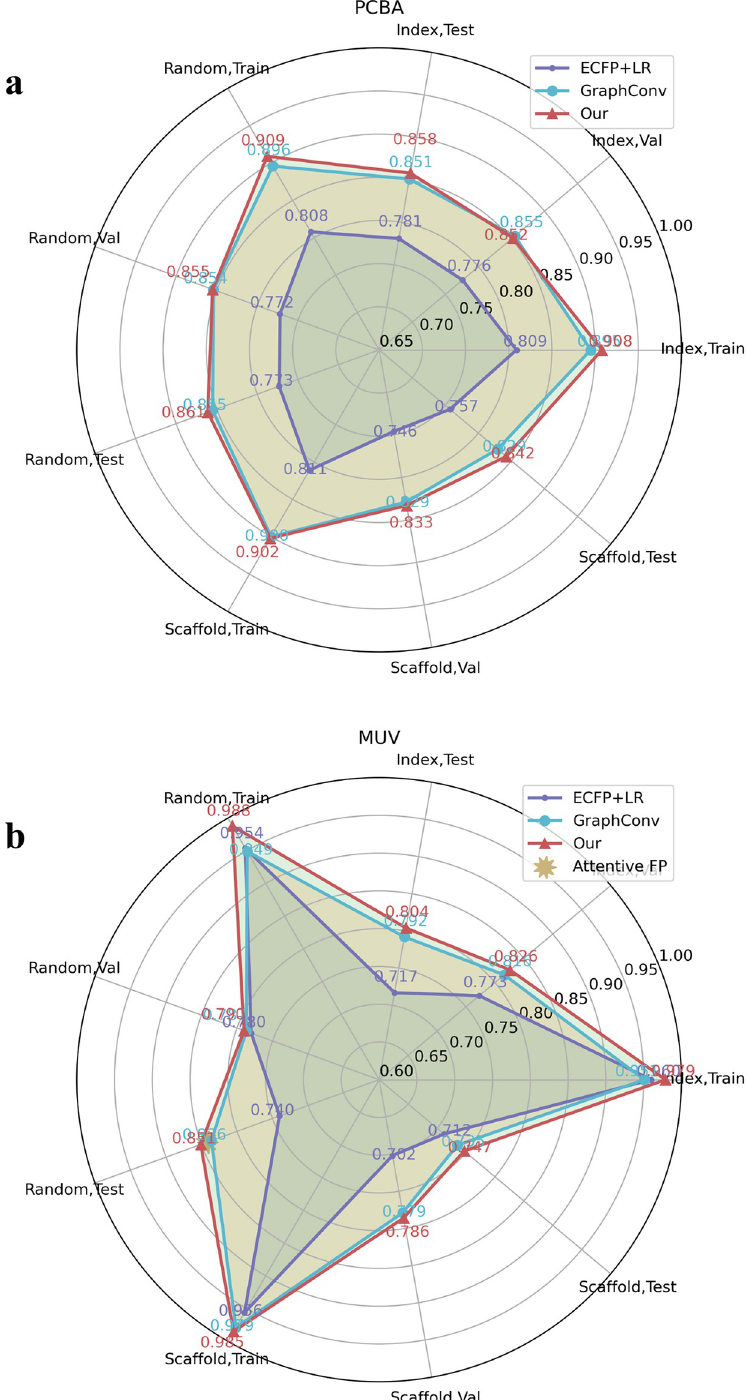
Fig 6. Performance comparison between our model and the baseline model in multitask classification tasks. The area under the curve (AUC) of the ROC curve of various models in the a PCBA and b MUV datasets.